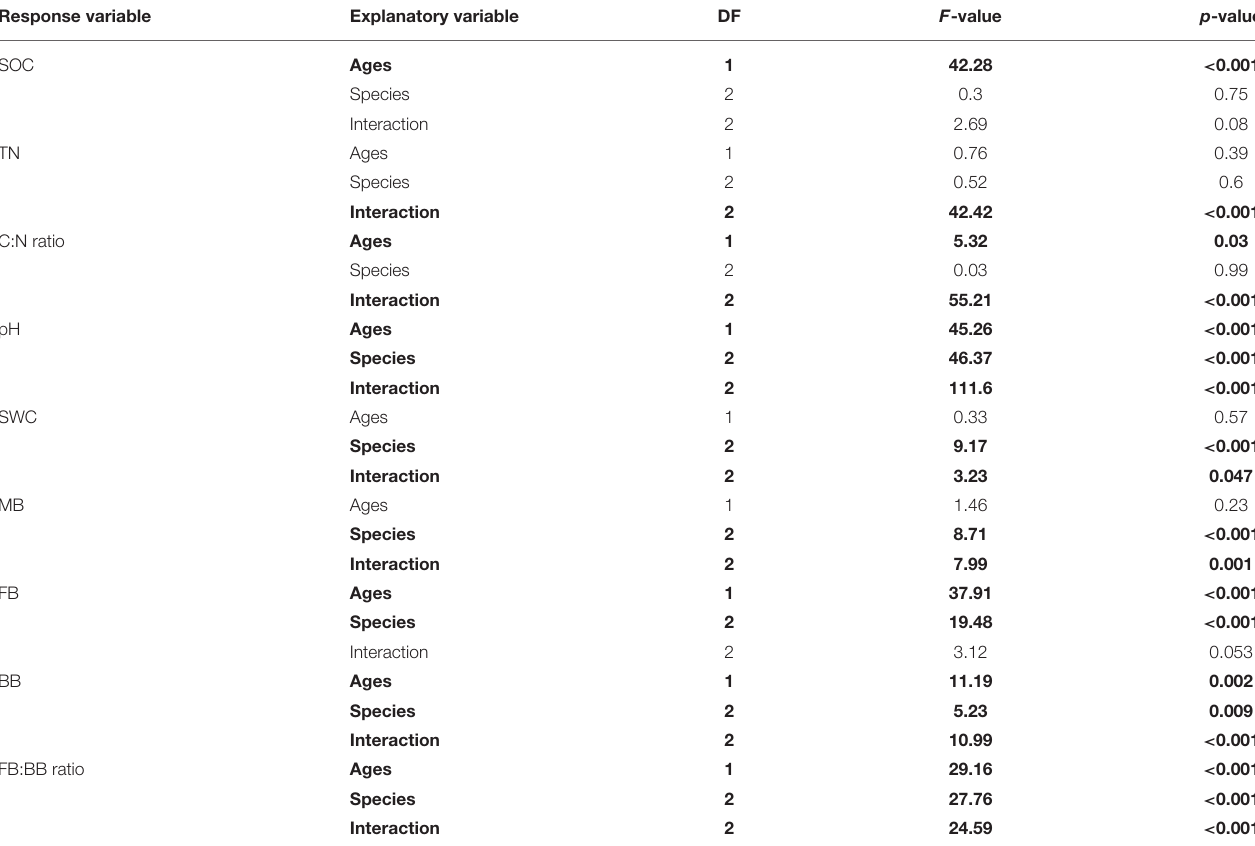
TABLE 2 | Summary of two-way ANOVA model for responses of physicochemical and microbial characteristics to explanatory variables of Eucalyptus plantation age, species, and their interaction. Response